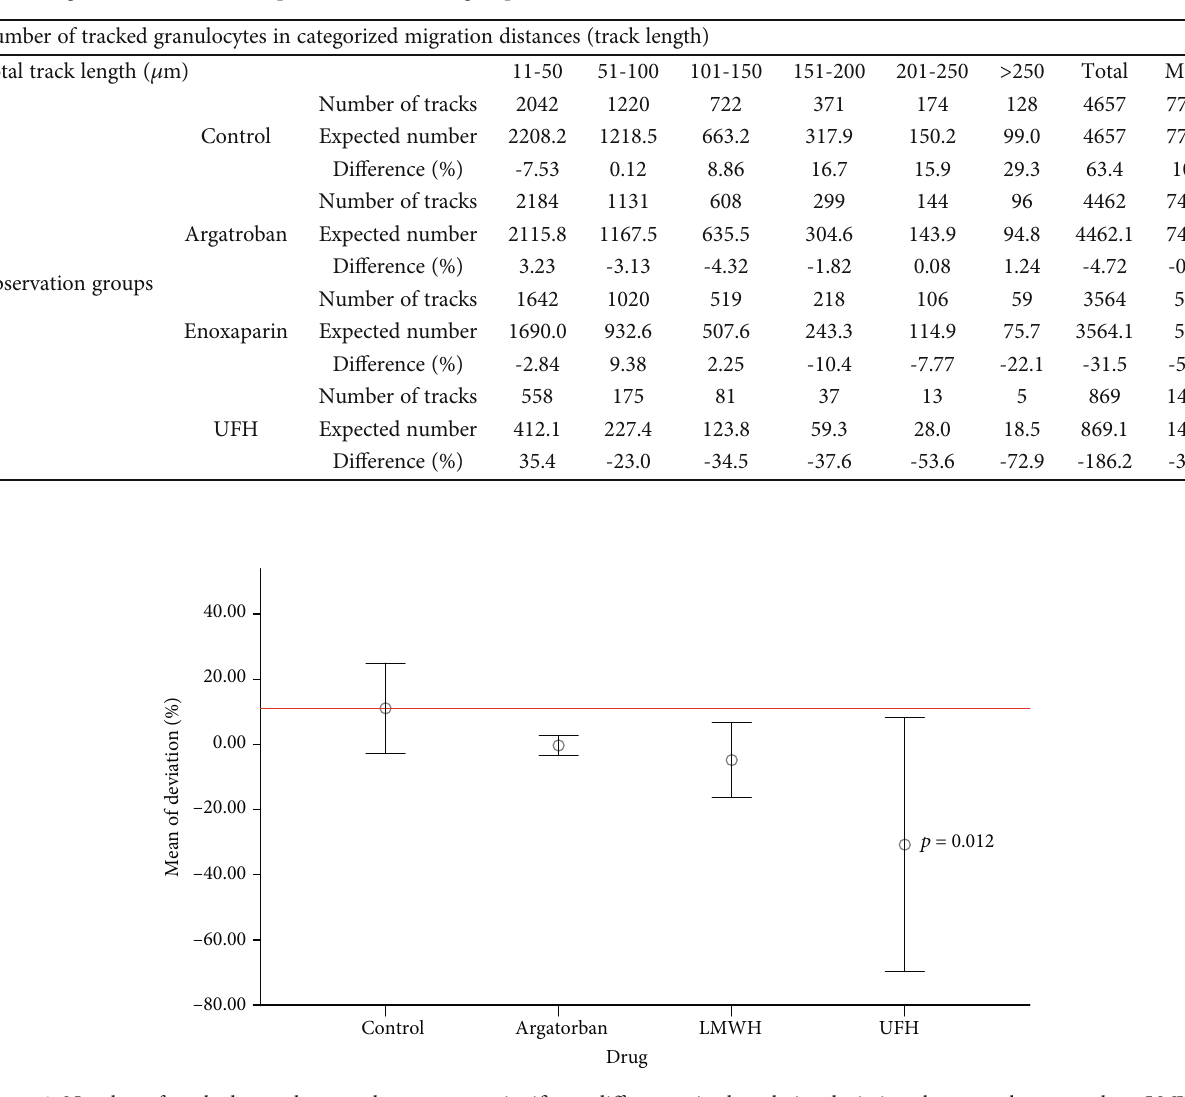
( 185 ± 36 : 6 min , n = 11 ) (Figure 4).